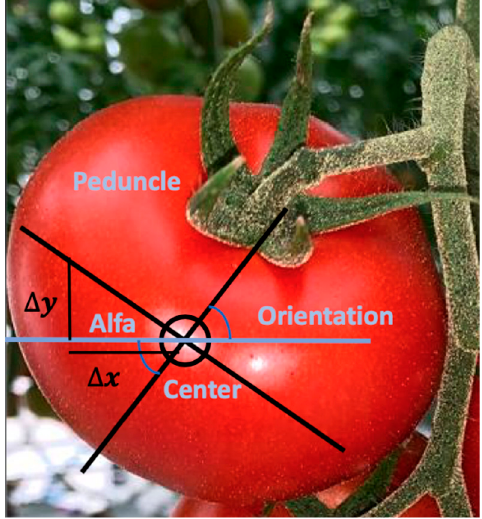
Figure 17. Geometric relationship based on tomato morphology.